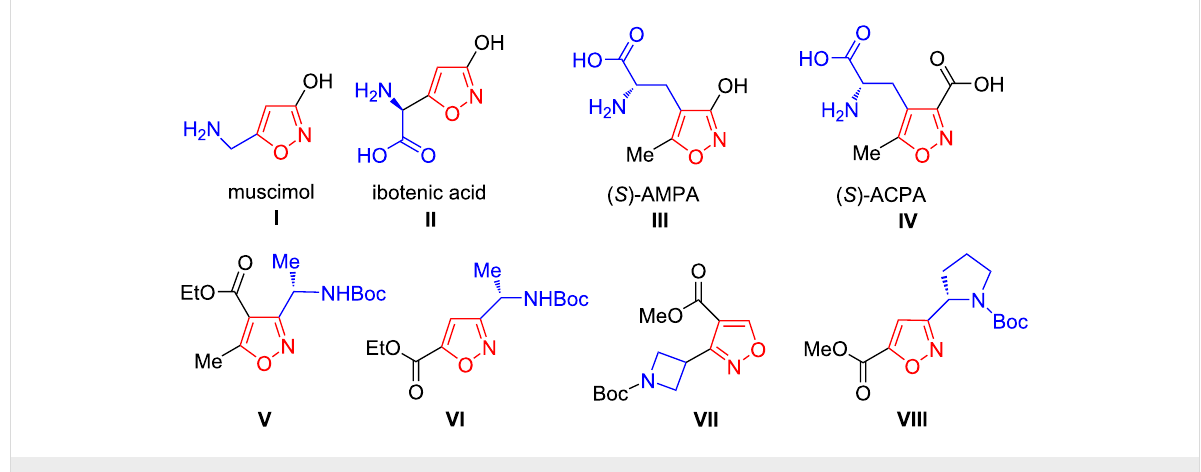
Figure 1: Examples of amino-functionalized 1,2-oxazole derivatives I – VIII .